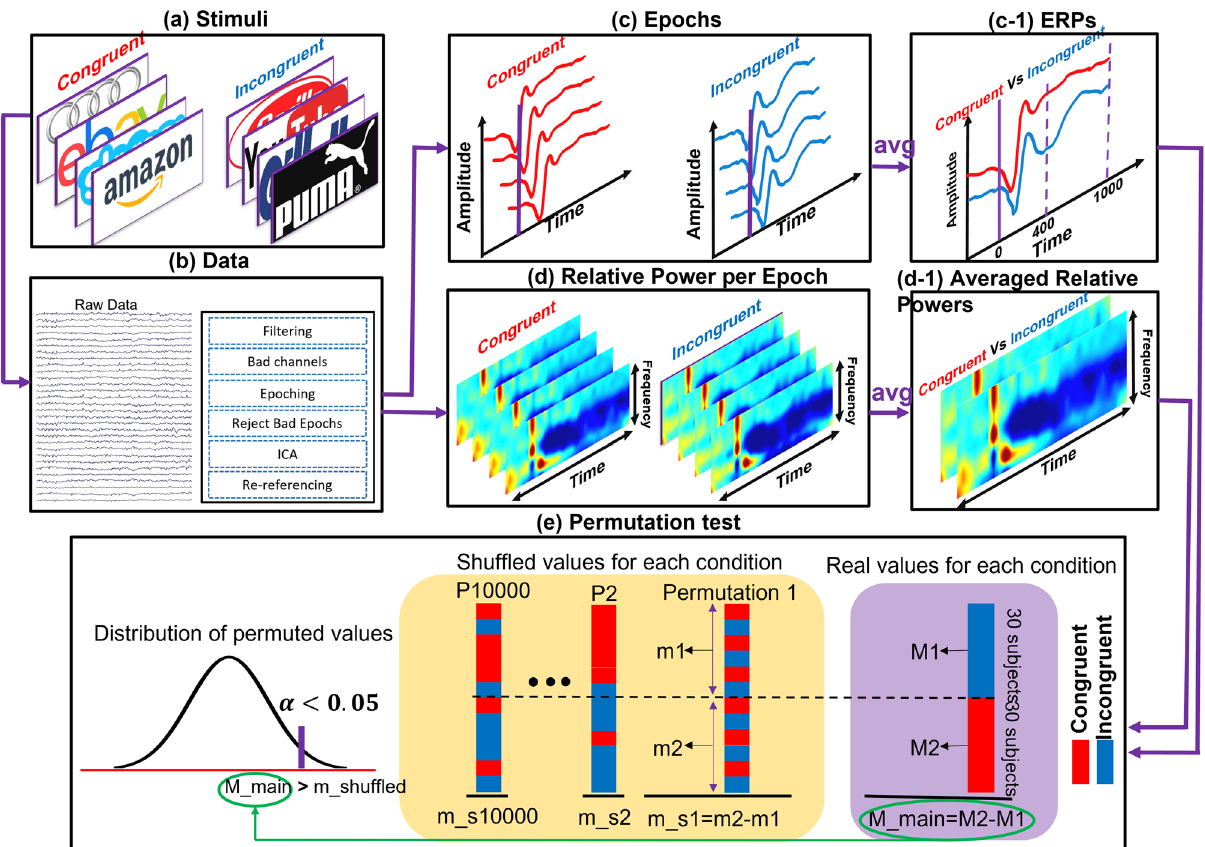
Figure 5. Shows the steps in our methodology. The plots related to congruent condition are indicated by red color, and incongruent condition by blue color. Panel ( a ) shows congruent and incongruent target brands (the last image of each set). Panel ( b ) shows an example of the EEG data followed by pre-processing steps. Panel ( c ) relates to pre-processed epochs corresponding to each condition. By averaging the epochs of each condition we reached panel ( c-1 ), showing the ERP activity for each condition. Panel ( d ) shows the time–frequency activity of each epoch for two conditions separately (in each TF, hot colors indicate positive relative power and cold colors indicate negative relative power). By averaging of TF of each condition, panel ( d-1 ) is obtained, showing the actual time–frequency activity of each condition. Panel ( e ) shows the statistical analysis using the permutation test—starting with actual difference calculation, then shuffling the extracted feature 10,000 times and calculating the difference in each iteration, and finally building up the random distribution and comparing it with the actual TF − averaged baseline TF = . (1) relative power averaged baseline TF